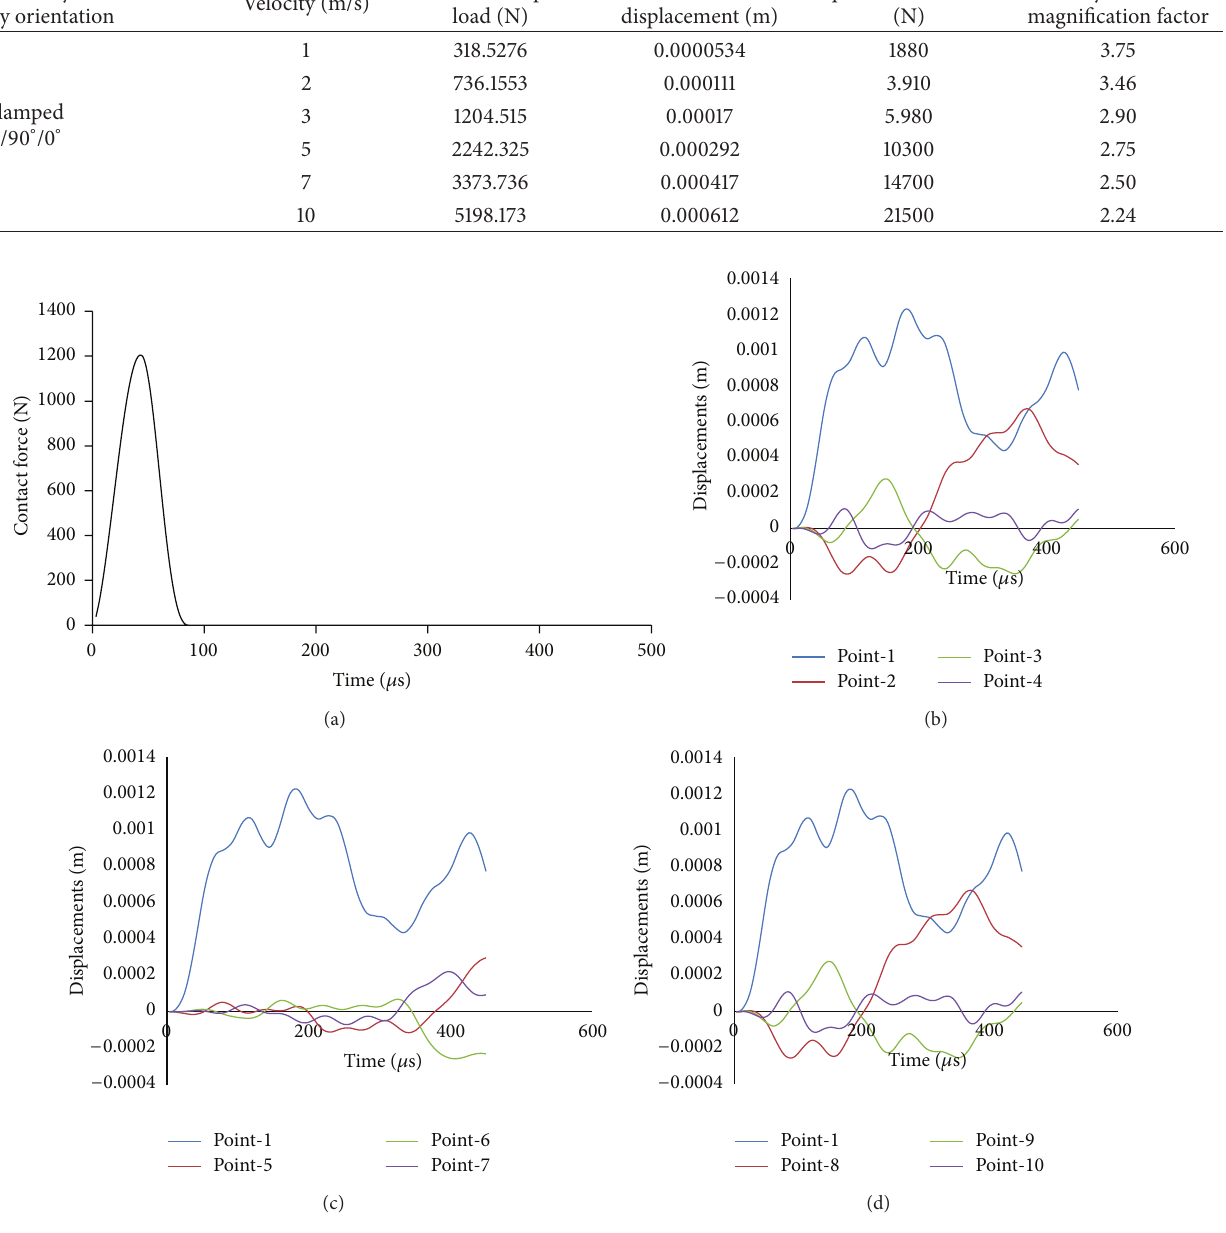
Figure 6: Impact response of clamped cross ply (CL/CP) composite hypar shells for impact velocity 3